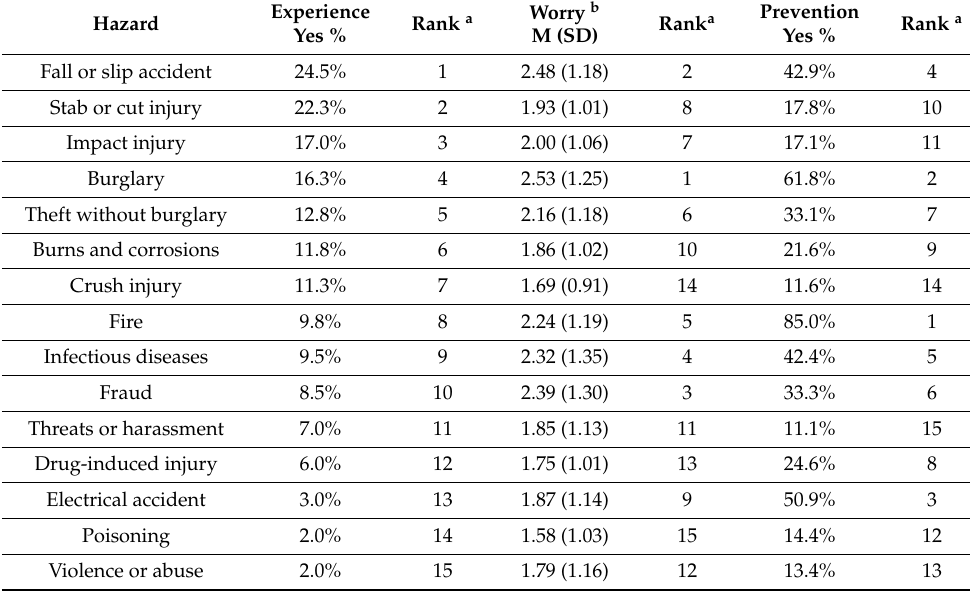
Table 2. Participants’ experience of, worry about, and preventive measures taken towards 15 home hazards. Hazard